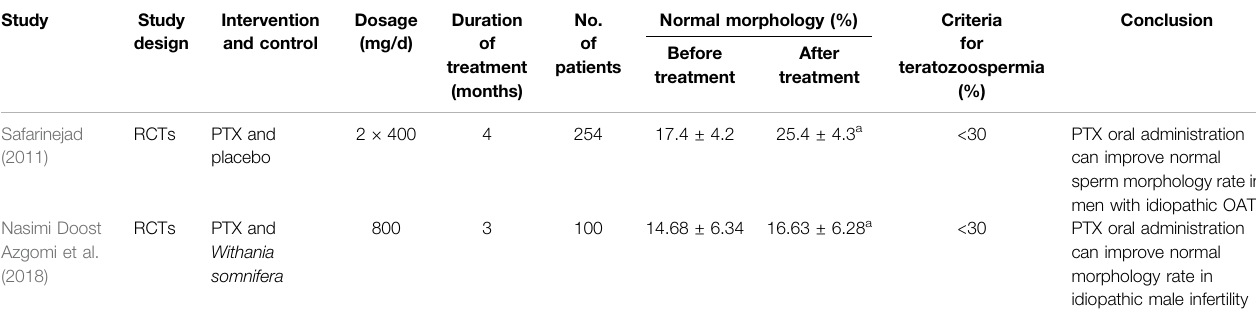
TABLE 3 | The effect of oral PTX on sperm morphology.